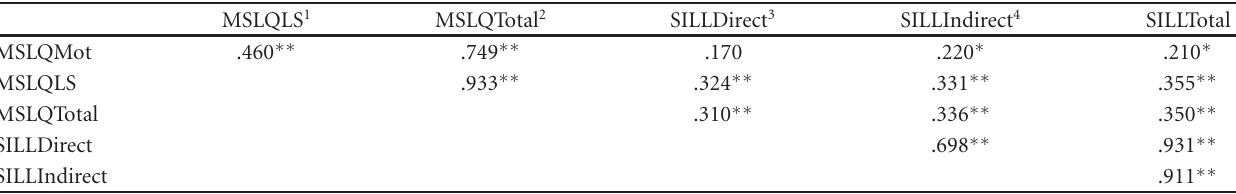
Table 3: Pearson correlation coe ffi cients for MSLQ and